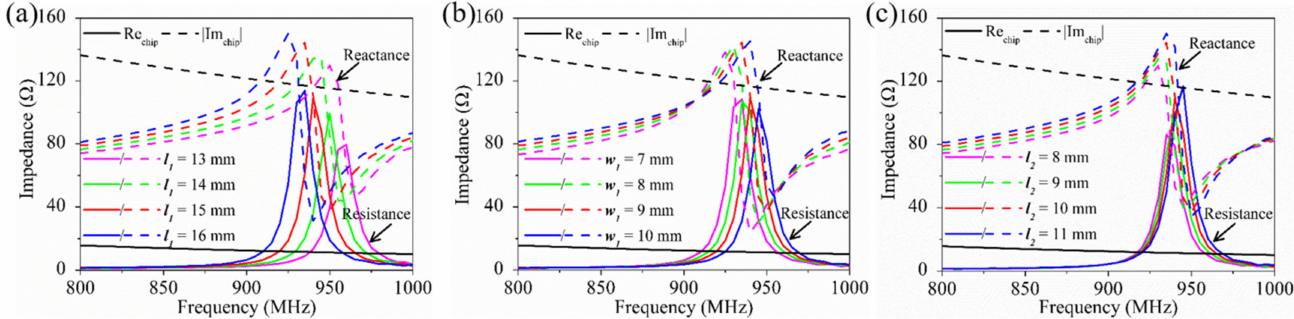
Figure 8. Simulated complex impedance of the antenna with different parameter values: ( a ) l 1 , ( b ) w 1 and ( c ) l 2